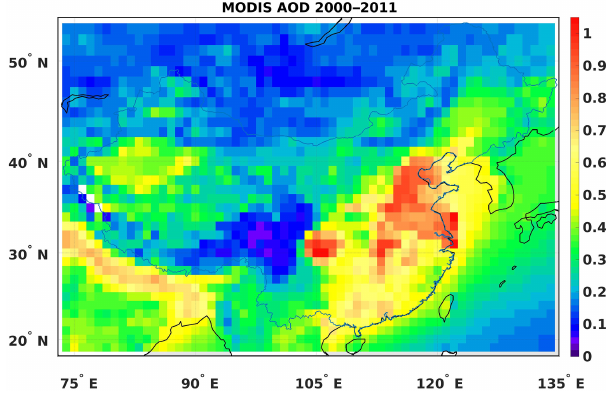
Figure 4. Difference between MODIS C6 and C5.1 merged DTDB AOD; see color scale on the right. Red colors indicate that C6 is higher; blue colors indicate that C5.1 is